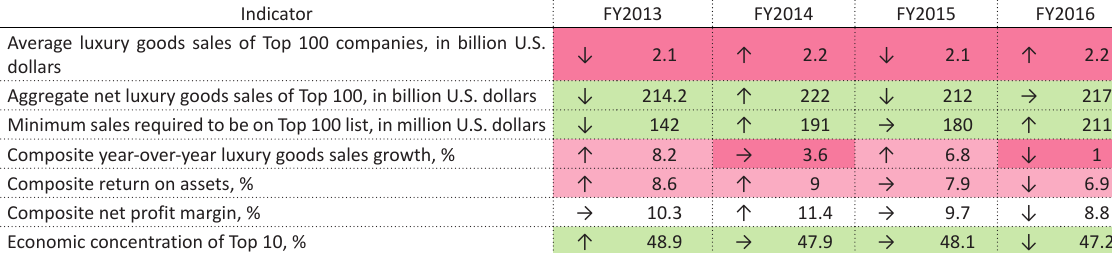
Table 1. The main data of the top 100 luxury companies from 2013 to 2016 Source: Created by the authors, based on Deloitte (2015), Deloitte (2016), Deloitte (2017), Deloitte (2018). Indicator FY2013